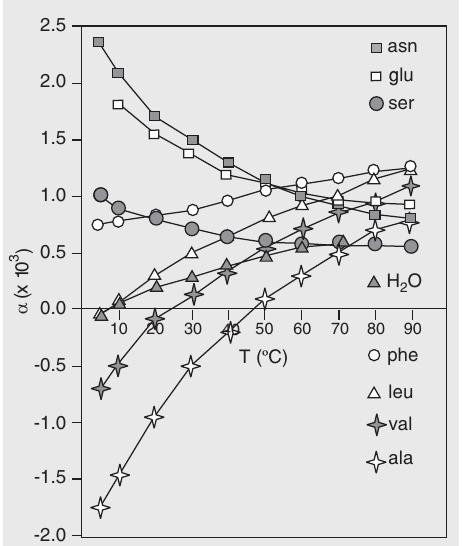
Figure 1. Expansivities of amino acids as a function of tempera- ture determined by pressure per- turbation calorimetry (PPC). The values of α were estimated from the data presented by Brandts and co-workers (45) and plotted on the same graph for compari- son. T =